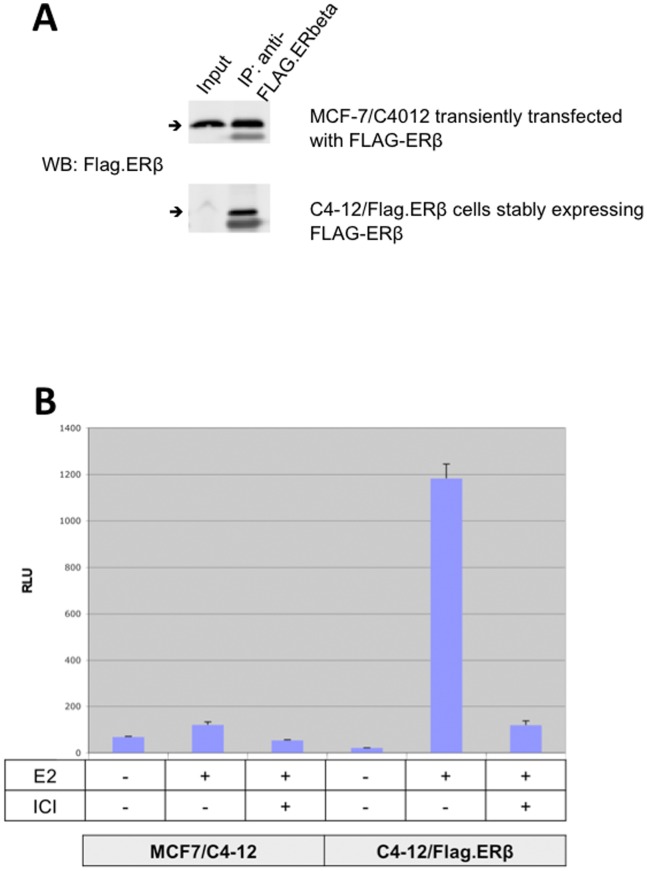
Validation of the C4–12/Flag.ERβ cell line.A – Flag.ERβ stably expressed in C4–12/Flag.ERβ cells was detected (because of low expression level, the ERβ band in the input lane was faint) and immunoprecipitated with anti-Flag antibody. Lysates of MCF-7/C4–12 cells transiently expressing Flag.ERβ were used as positive controls. B – Luciferase reporter assays confirmed the expression of a functional ERβ in C4–12/Flag. ERβ cells. C4–12/Flag.ERβ cells were cultured in 48-well plates, then transfected with 3xERE-Luc and RTK plasmids. After 24 hours of treatment with 10 nM E2 or Vehicle (Ethanol), cells were lysed with Passive Lysis Buffer (Promega) and processed with Dual Luciferase Assay (Promega). (RLU = relative light units; error bars = standard deviation).